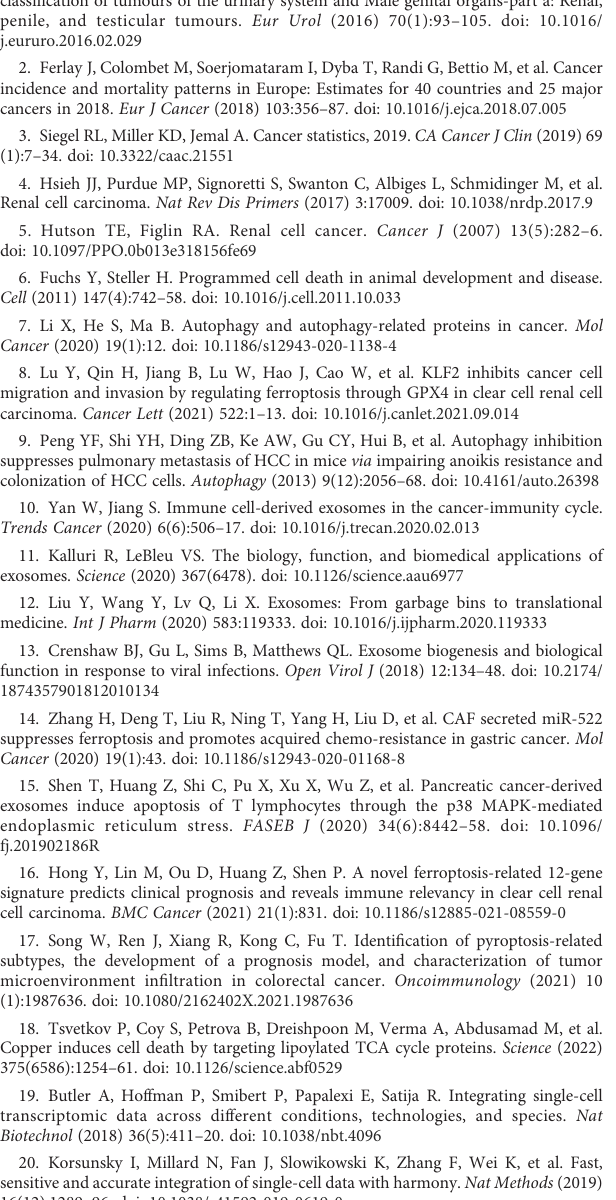
SUPPLEMENTARY FIGURE 8 Analysis of cell – cell signal interaction pathway networks for cell clusters. Circos plot showing putative ligand – receptor interactions between each cell cluster, withtheweightofinteractionsindicatedbythethicknessoftheconnectinglines. SUPPLEMENTARY FIGURE 9 Bubble plot of tumor cell ligand – receptor interactions in the tumor microenvironment. Summary of selected ligand – receptor interactions between different cell clusters between TRIB3 high tumor epithelial cells and other cell types. The P -values are indicated by the size of each circle. In contrast, the color gradient indicates the level of